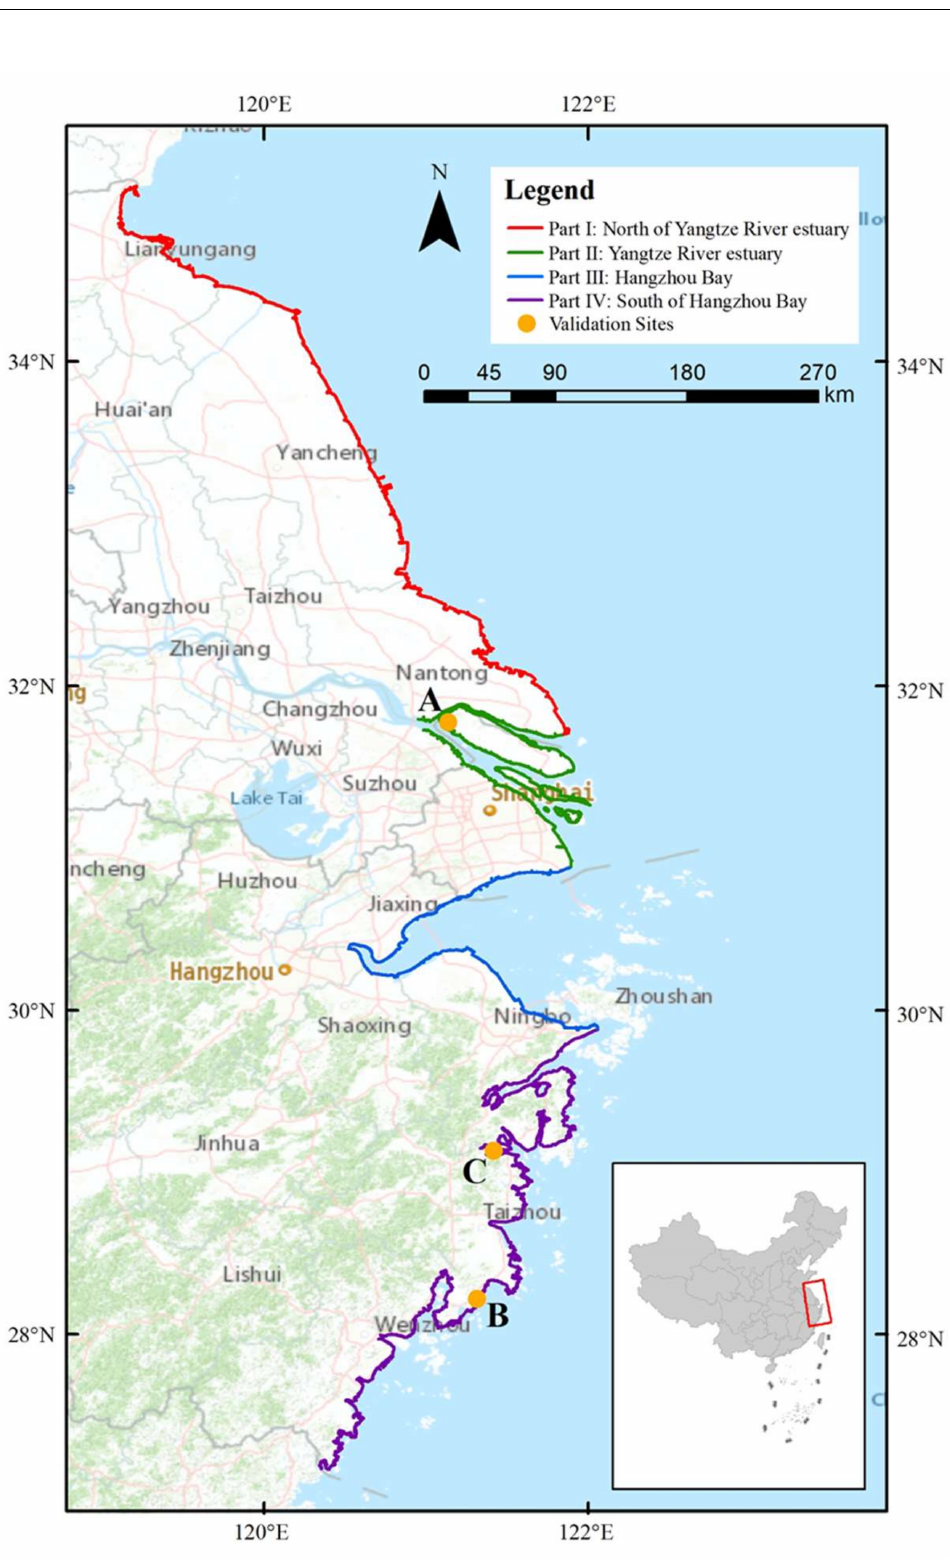
Figure 1. Location and division of the study